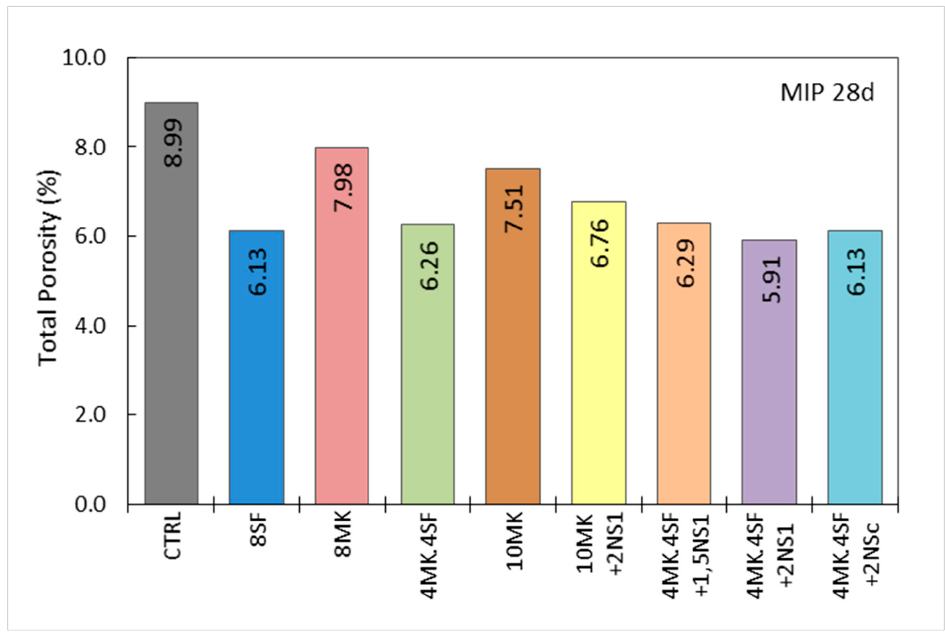
Figure 9. Curves of the thermogravimetric derivative according to temperature ranges.